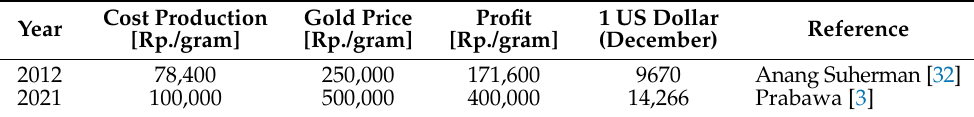
Table 3. Gold Cost Production of ASGM.